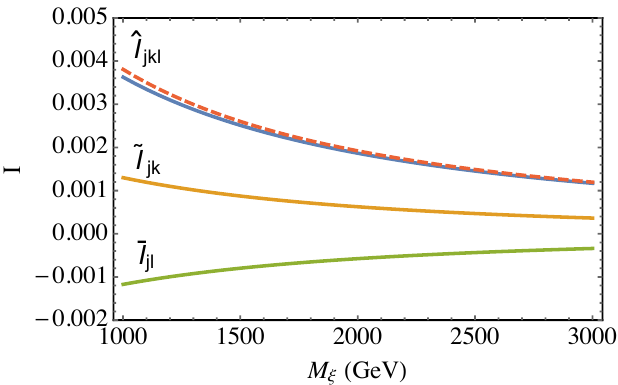
Figure 3 . The plot of loop integral of each diagram. The solid line represents the case with the top quark inside the loop, while the dashed line represents the case with the charm quark. It is obvious that the loop integrals depend mildly on fermion masses. Here we use M S = 1200 GeV, M R = 1501 GeV, µ = 10 GeV, and λ = 1 .